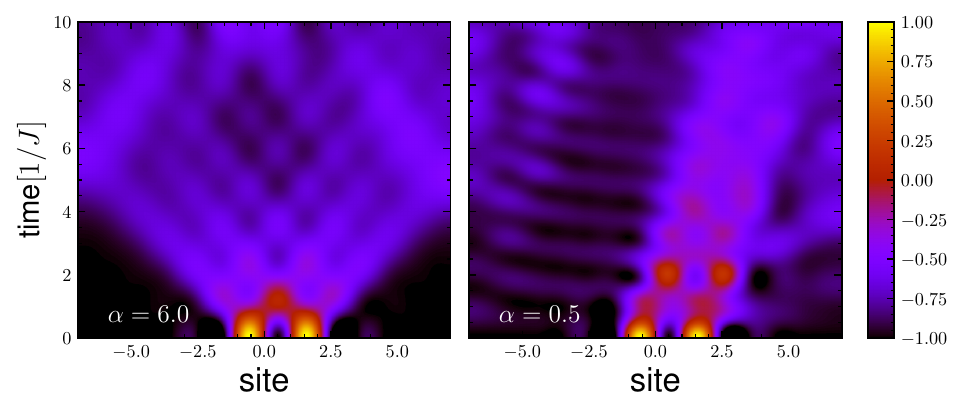
Figure 6: (color online) Numerical exact results of spatially and temporally resolved 〉 spin polarisation 〈 σ z of XXZ model (see Eq.(1)) with ∆ = 1.5 for D = 1.0 at short t i ( α = 6.0, left panel) and long ( α = 0.5, right panel) range interacting